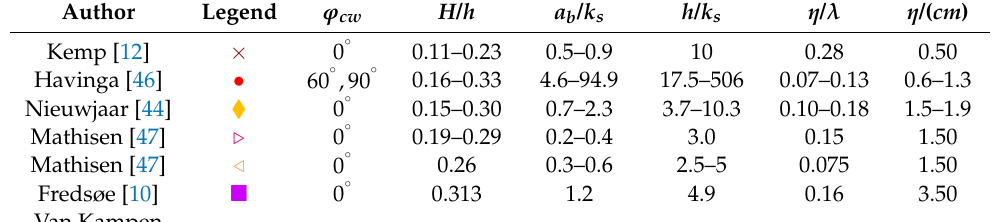
Table 2. Experiments conditions. The legends in the table are applicable to Figure 6a–d.